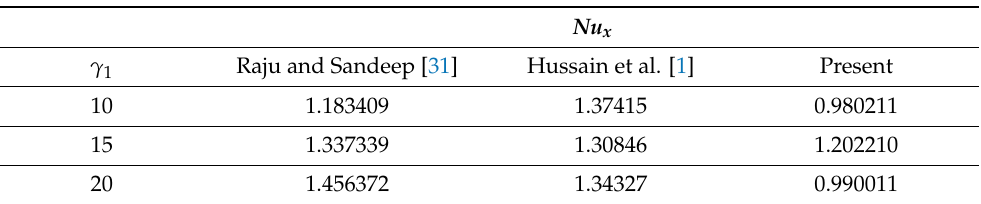
Table 2. Comparison of Nusselt number ( Nu x ) with already published work of Hussain et al. [19]. Raju and Sandeep [31].